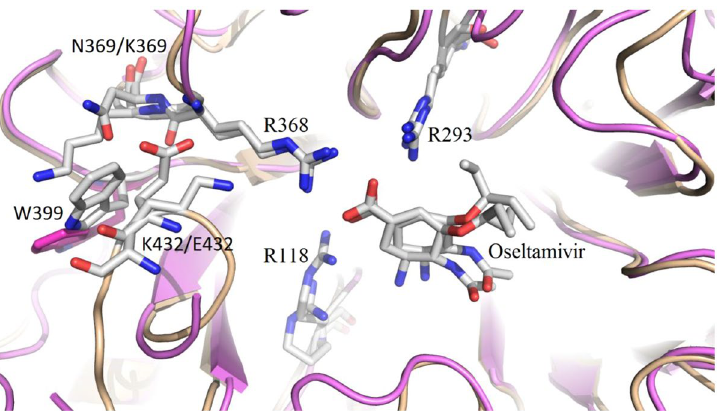
Figure 4. Alignment of the N369K and K432E mutations. The positively-charged domain of the binding pocket is split apart from the four positive residues(K432, R368, R293 and R118) into three as a result of the double mutations. The significant shifting of W399 is highlighted by the pink-coloured stick. Wild-type NA is denoted in violet, and the N369K/K432E NA is in